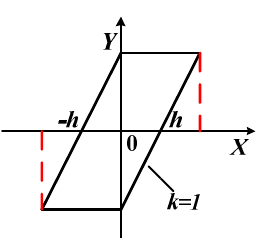
Figure 1. Dead zone characteristics of governor.